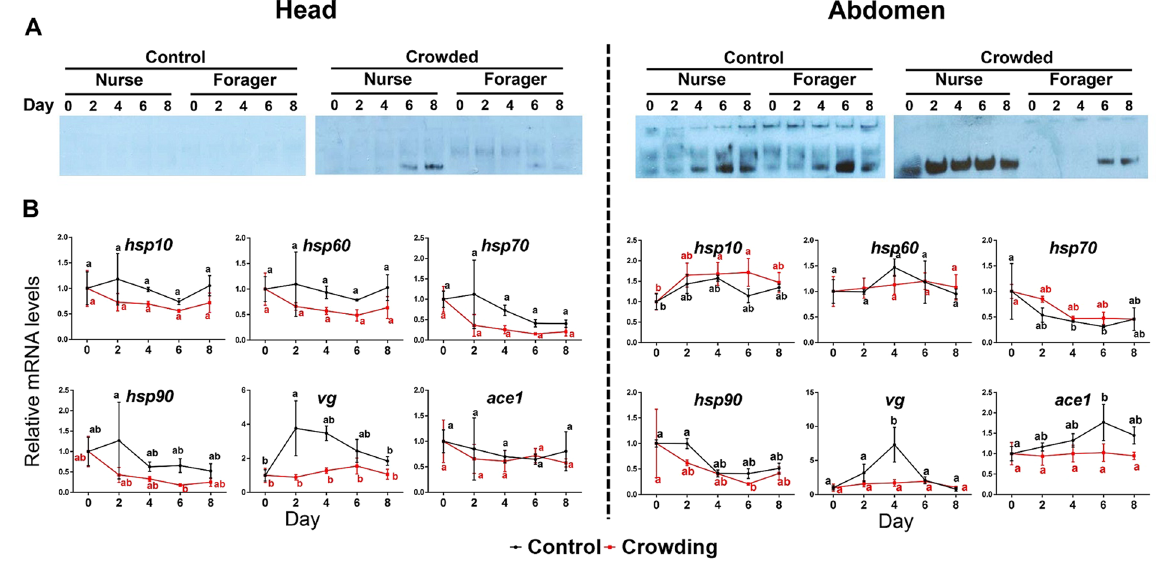
Figure 2. AmAChE1 expression profile and qPCR results of stress marker genes in the head ( A ) and abdomen ( B ) of honey bees following crowding. Two different colonies with similar densities were selected and the density of one was doubled by transferring honey bees from a super into the bottom hive. Honey bees were collected on day 0, 2, 4 and 8. The data was analyzed by two-way ANOVA followed by Tukey’s multiple comparison, and significant differences were marked with * ( p < 0.05), ** ( p < 0.01) and *** ( p < 0.001).